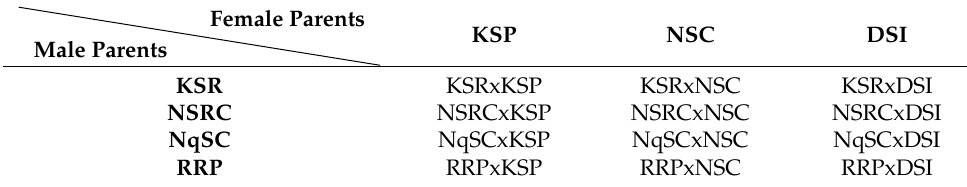
Table 9. Arrangement of North Carolina Design II for